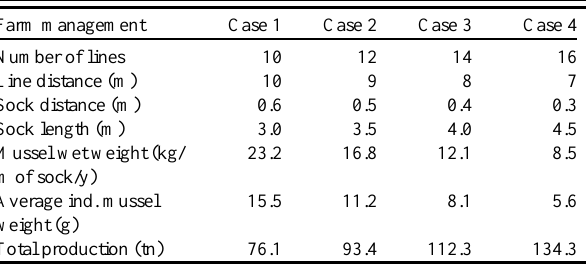
Table 6 . Effects of individual farm characteristics on farm